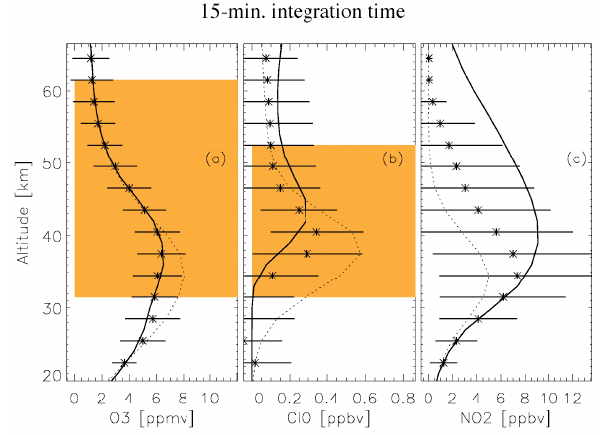
Fig. 9. Same as Fig. 8 but for nighttime profiles.